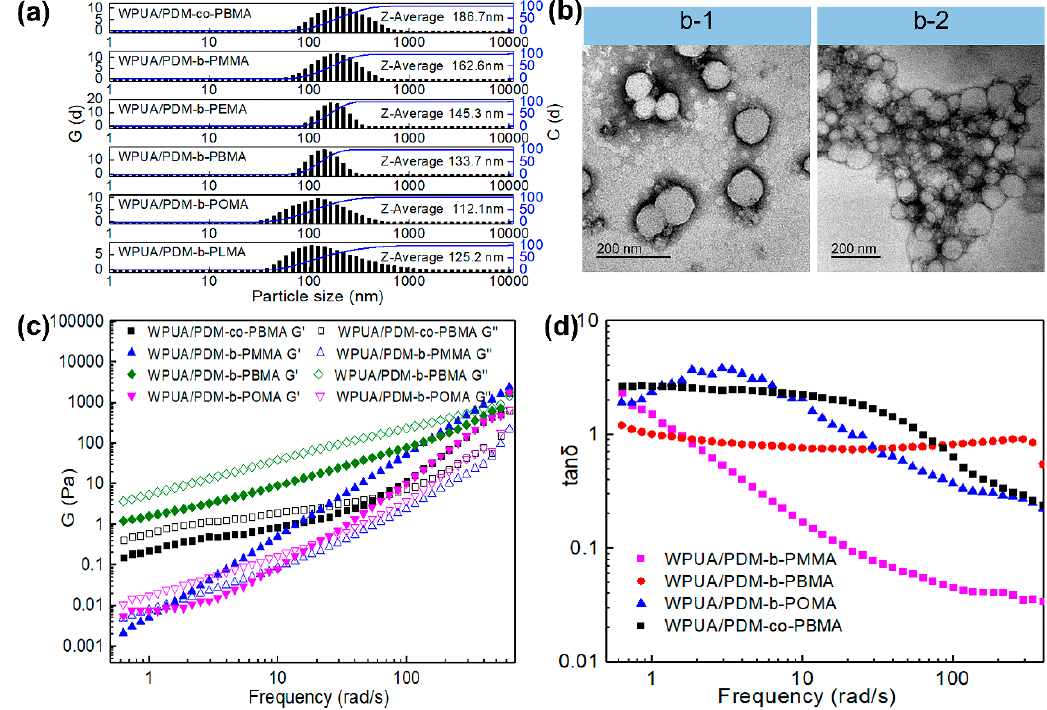
Figure 10. E ff ects of PDM- b -PRMA and PDM- co -PBMA on micelle size of WPUA / PDM-b-PRMA Figure 10. Effects of PDM- b -PRMA and PDM- co -PBMA on micelle size of WPUA/PDM-b-PRMA and and WPUA / PDM- co -PBMA nanoemulsions ( a ). TEM images ( b ) of WPUA / PDM- b -PBMA ( b-1 ) and WPUA/PDM- co -PBMA nanoemulsions ( a ). TEM images ( b ) of WPUA/PDM- b -PBMA ( b-1 ) and WPUA / PDM- co -PBMA ( b-2 ). E ff ect of PDM- b -PRMA and PDM- co -PBMA on storage modulus and WPUA/PDM- co -PBMA ( b-2 ). Effect of PDM- b -PRMA and PDM- co -PBMA on storage modulus and loss modulus of nanoemulsions ( c ). E ff ect of PDM- b -PRMA and PDM- co -PBMA on loss angle tan δ of loss modulus of nanoemulsions ( c ). Effect of PDM- b -PRMA and PDM- co -PBMA on loss angle tan δ of nanoemulsions ( d nanoemulsions ( d ).